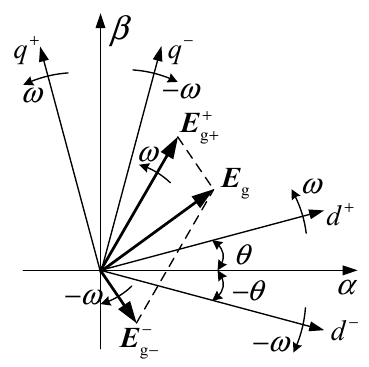
Figure 3. Space vector of the gird voltage in the positive sequence (PS) and negative sequence (NS) synchronous reference frame (SRF).